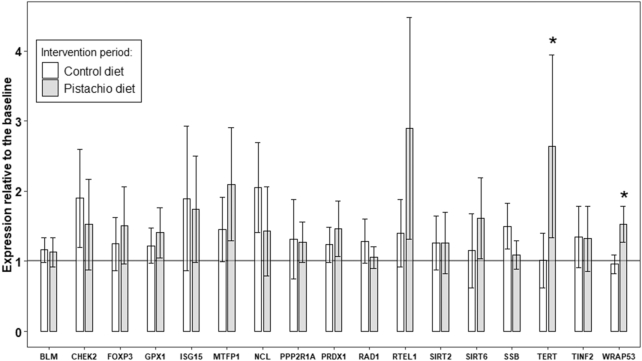
Expression relative to the baseline of the genes across intervention diets. Data are given as means (95% CI). Values equal to 1 mean the same expression at baseline and at the end of a particular period, whereas values >1 mean upregulation throughout the intervention period and <1 mean downregulation. *Significant differences in changes between dietary interventions (P < 0.05). n = 49, both periods are considered.